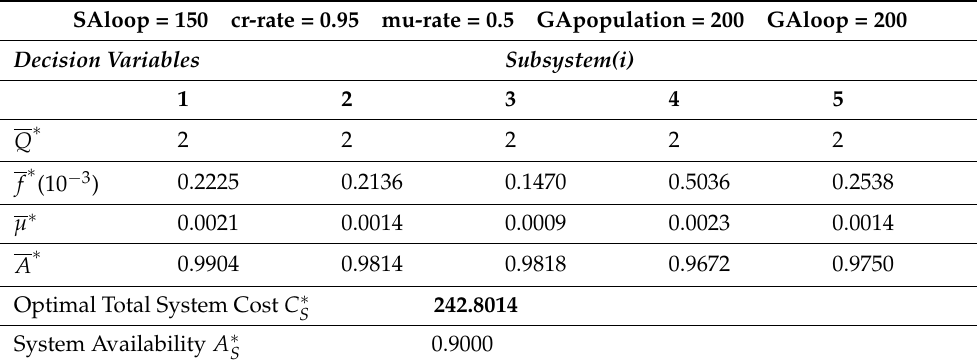
Table 30. Optimal Solutions obtained by SA–MGA for the for the n -stage q /2-out-of- q system. SAloop = 150 cr-rate = 0.95 mu-rate = 0.5 GApopulation = 200 GAloop =